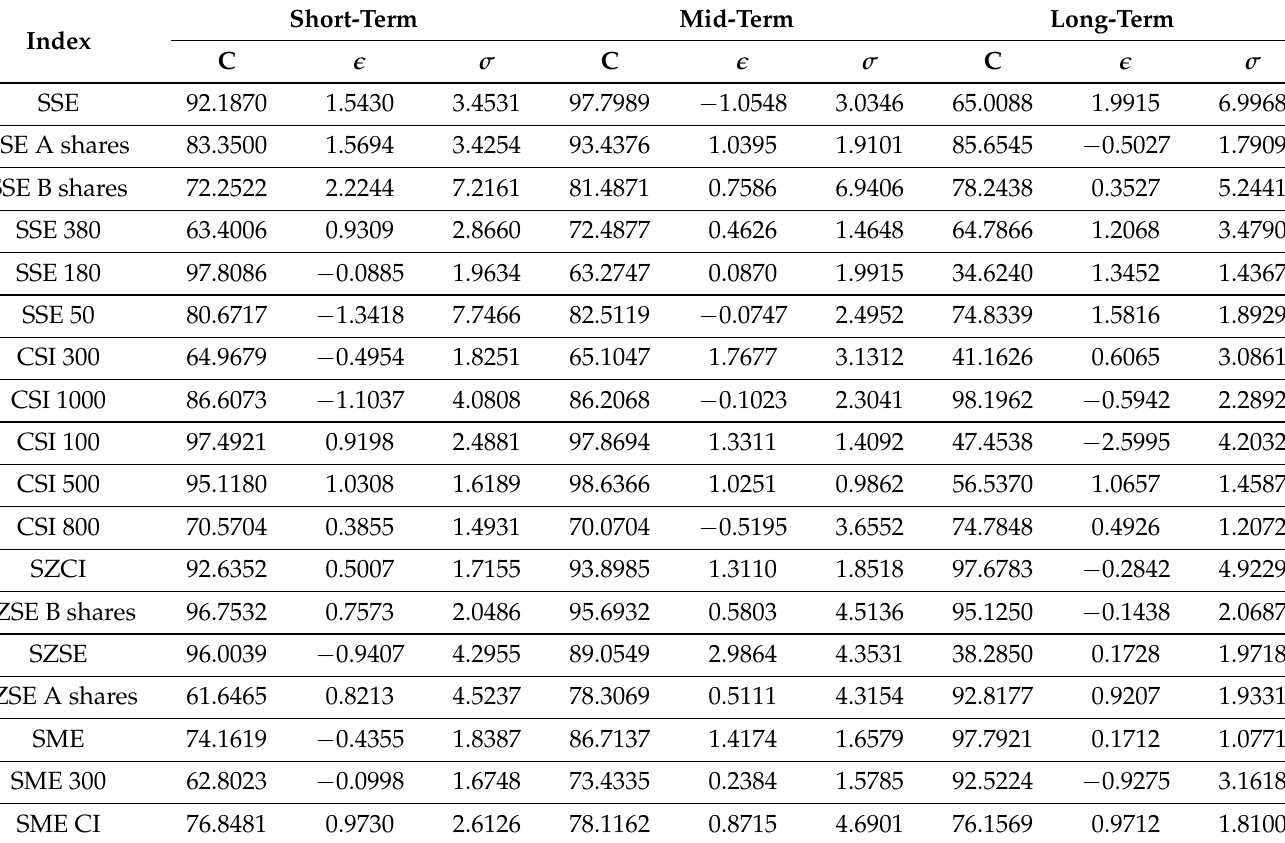
Table 14. SVR parameters obtained by bat algorithm